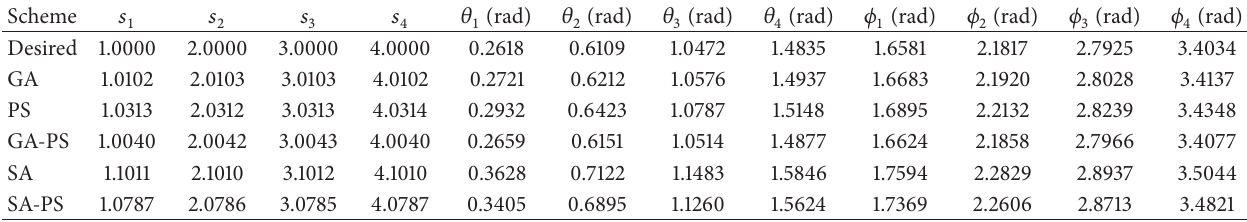
Table 6: Performance of 2-L-type array for 4 sources.